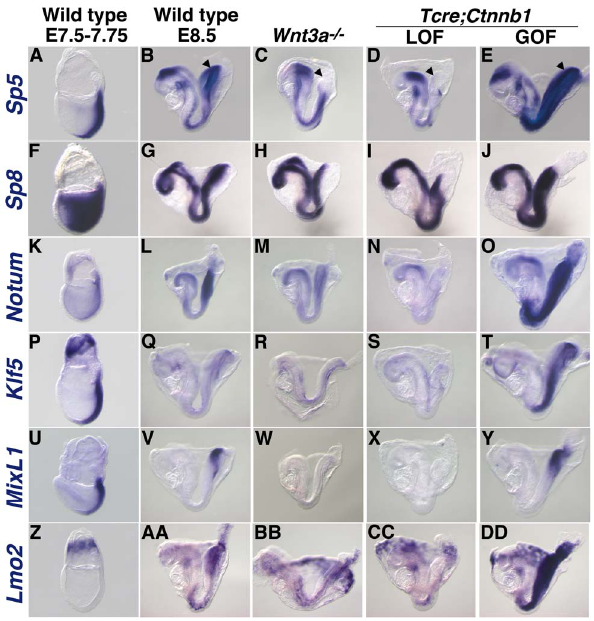
Figure 2. Validation of candidate Wnt3a target gene expression in Wnt3a and Ctnnb1 mutants by WISH. A comparison of Sp5 (A–E), Sp8 (F–J), Notum (K–O), Klf5 (P–T), MixL1 (U–Y), and Lmo2 (Z-DD) expression in wild type (A, B, F, G, K, L, P, Q, U, V, Z and AA), Wnt3a 2 / 2 (C, H, M, R, W and BB), Tcre;Ctnnb1 flLOF (D, I, N, S, X and CC) and Tcre;Ctnnb1 flGOF (E, J, O, T, Y and DD) embryos at E7.5 and 8.5 (LOF: loss- of-function; GOF: gain-of-function). Arrowhead in B–E points to the PS.